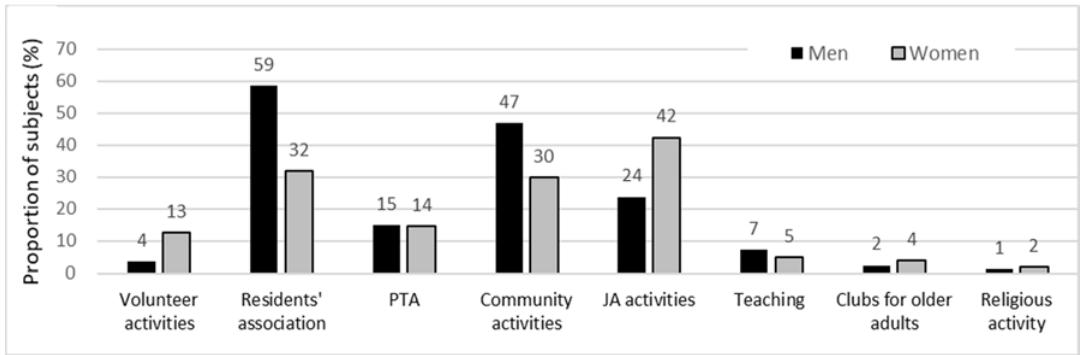
Table 3. Description of work environment characteristics by gender.